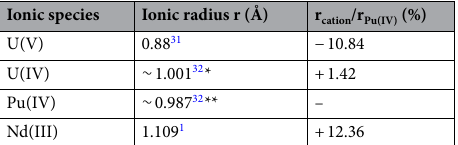
Table 2. Ionic radii ratios r cation /r Pu(IV) of the doping species in fluorite Nd- and Pu-doped UO 2 . *Calculated with a UO 2 equal to 5.47127(8) Å at 298 K 15 . **Calculated with a PuO 2 equal to 5.3957(5) Å at 298 K 16 .